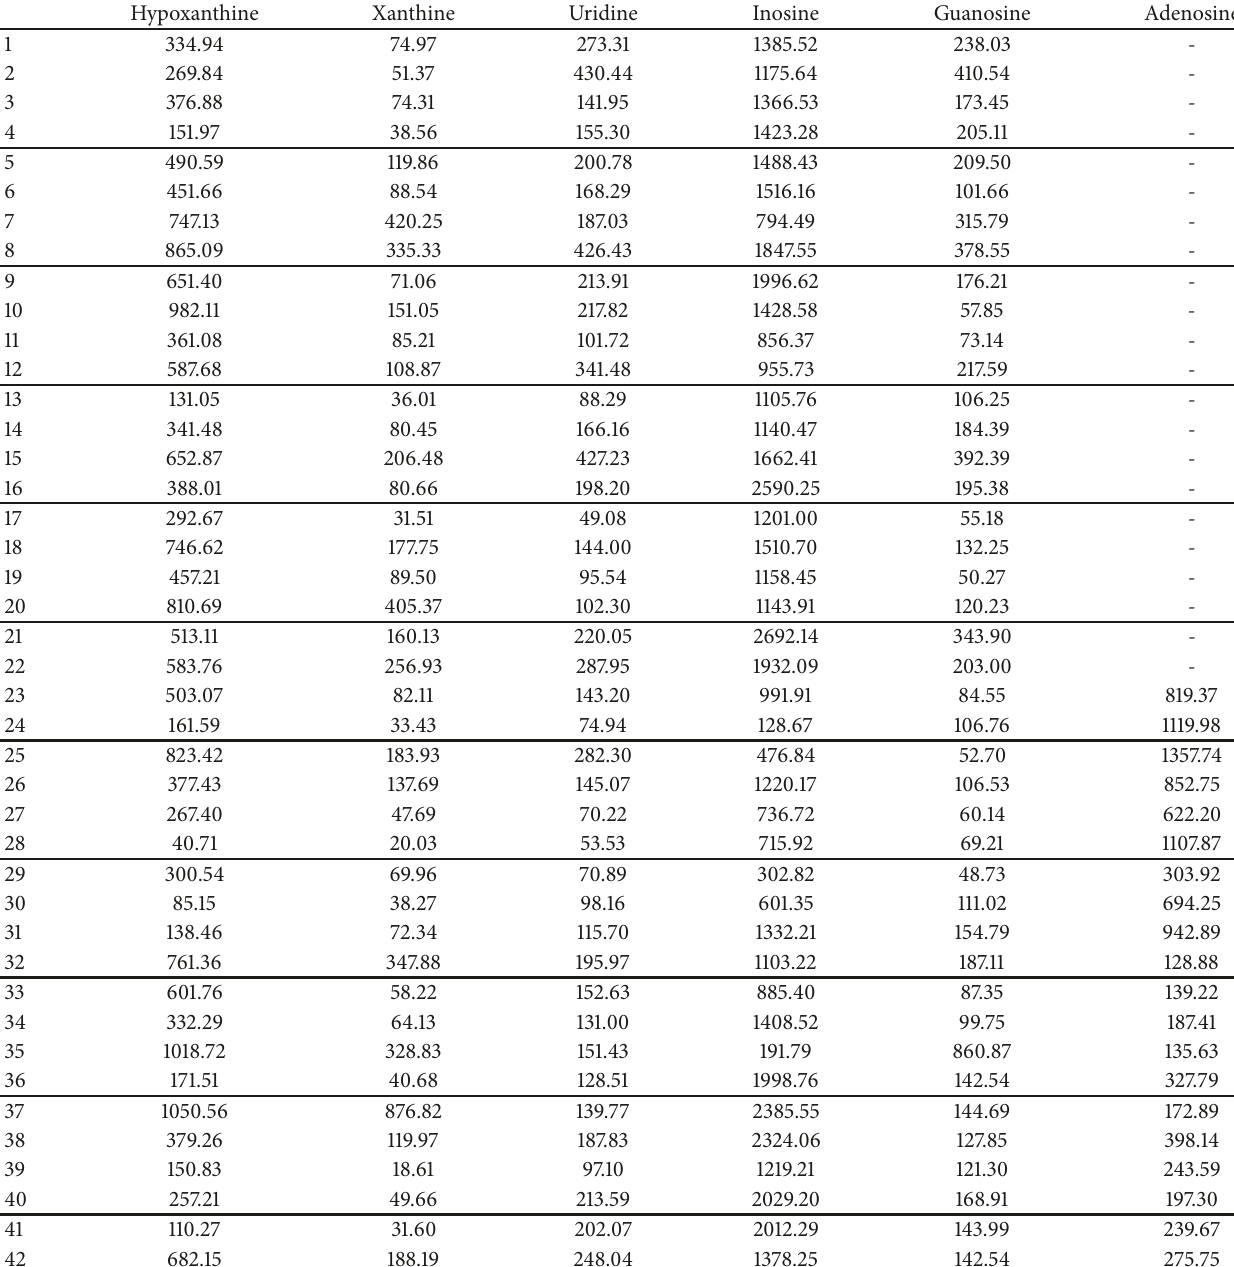
Table 4: Content of six components in 42 batches of commercial Guang Dilong, 𝜇 g/g, n =